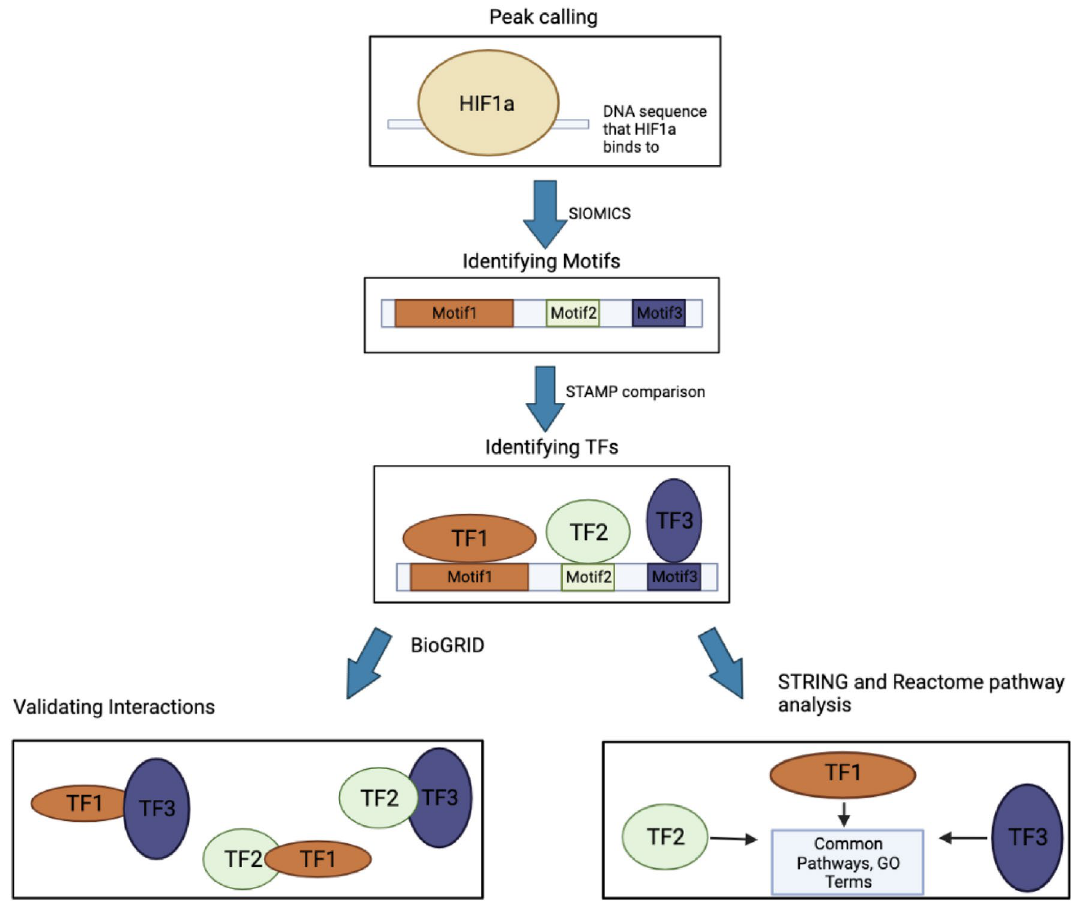
Figure 1. The pipeline to study hypoxia motifs and cofactor